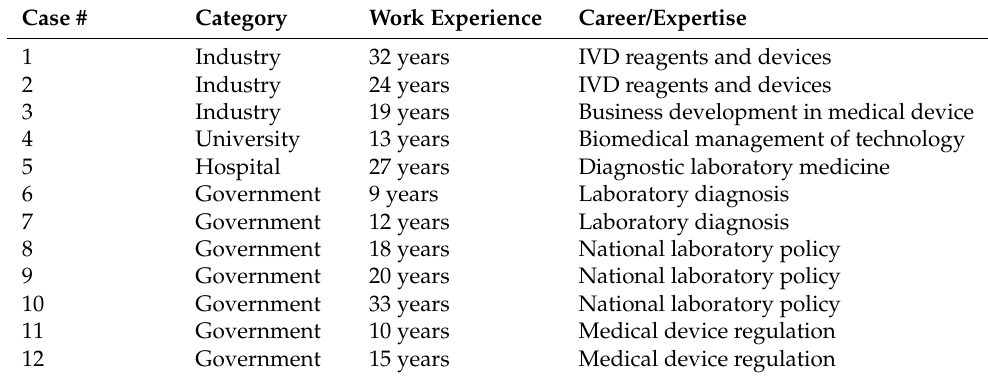
Table 2. Features of each interviewee.